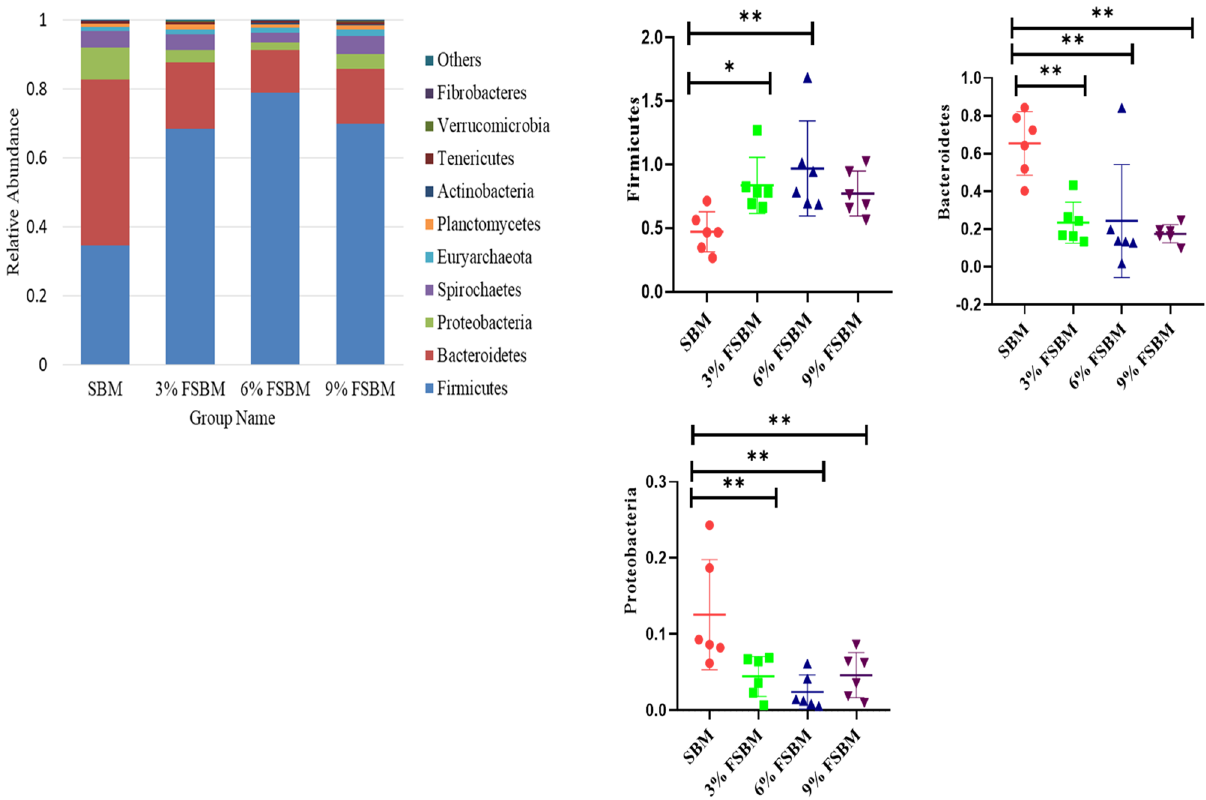
Figure 6. Effects of dietary FSBM on fecal microbial composition at the phylum level. * P < 0.05, ** P < 0.01, and *** P < 0.001. SBM, soybean meal; FSBM, fermented soybean